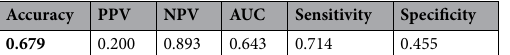
Table 2. Results of ROC curve analysis on POD 3 (cutoff value, 220 mg/L). AUC, area under the curve; NPV, negative predictive value; POD, postoperative day; PPV, positive predictive value; ROC, receiver operating characteristic.